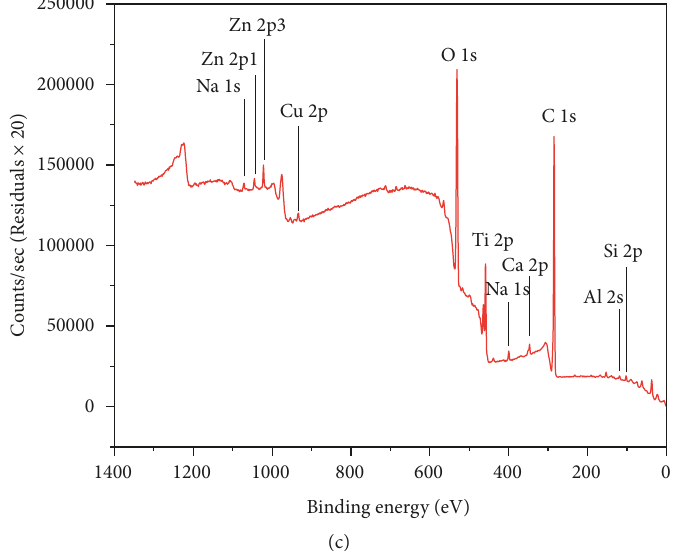
Figure 6: The SEM images electropolished Ti-6Al-4V specimen in (a) electrolyte 1, (b) electrolyte 2, and (c) electrolyte 3 and original 3D surface profile of specimen in (d) electrolyte 1, (e) electrolyte 2, and (f) electrolyte